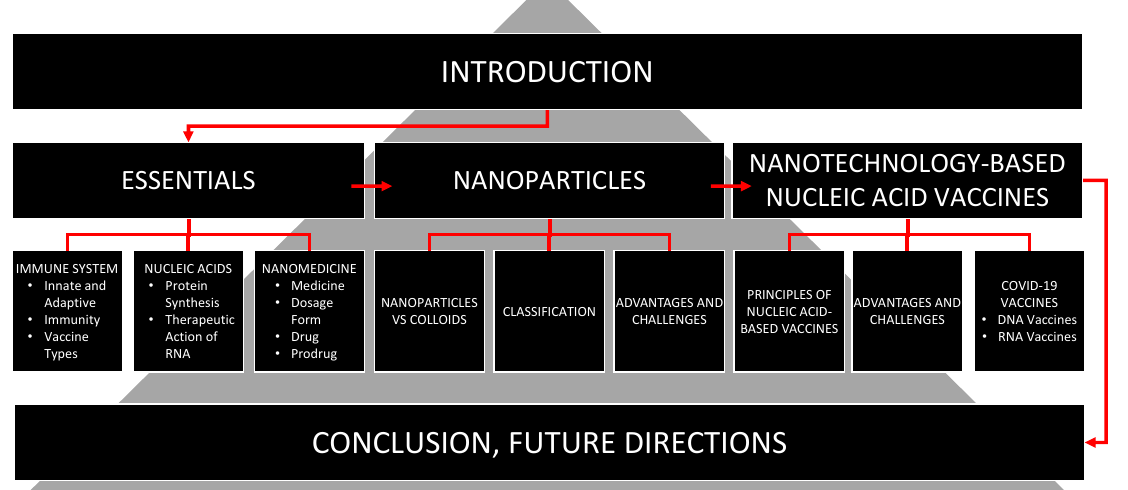
Figure 1. Structure of the review.